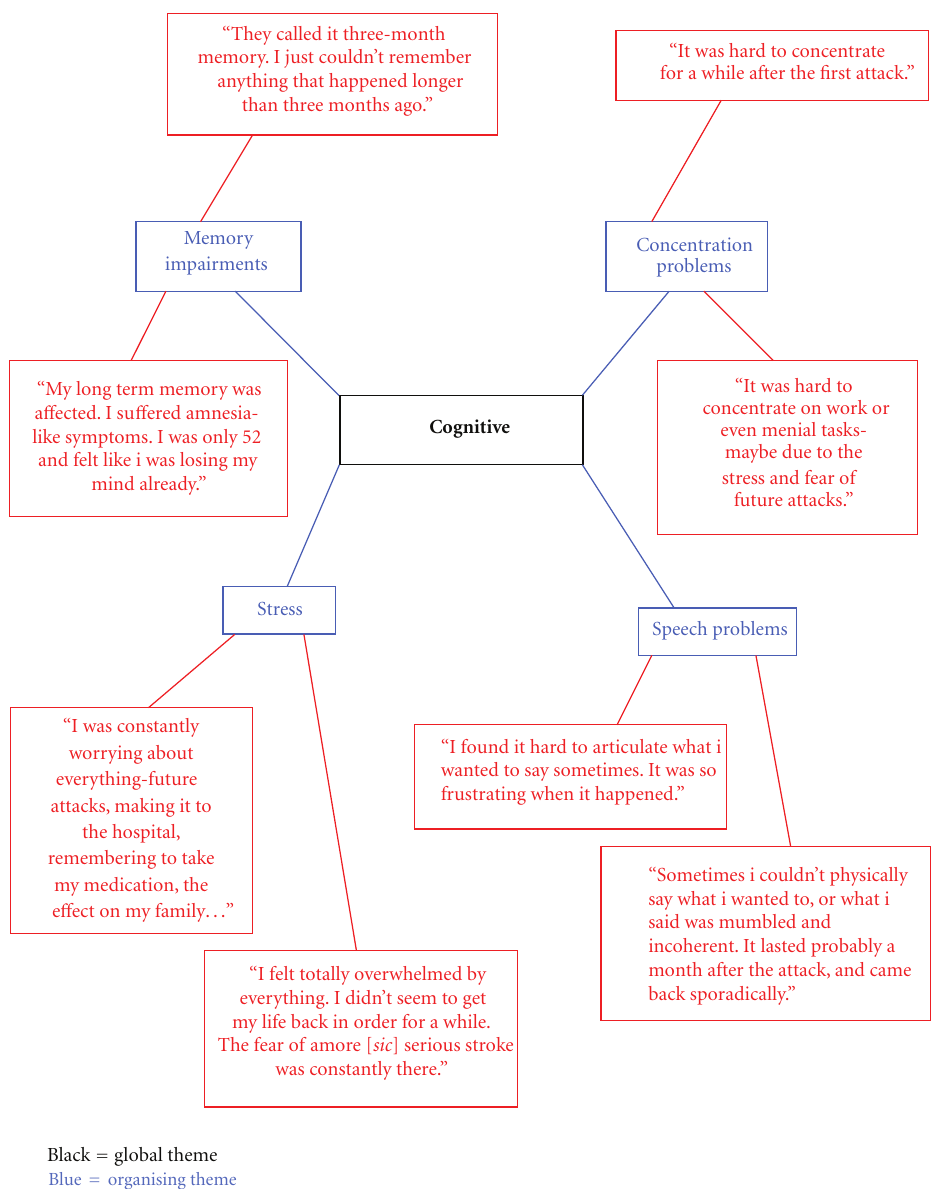
Figure 2: Simplified thematic analysis of cognitive problems post-TIA (selected basic themes in red outer boxes, organising themes in blue, global theme in